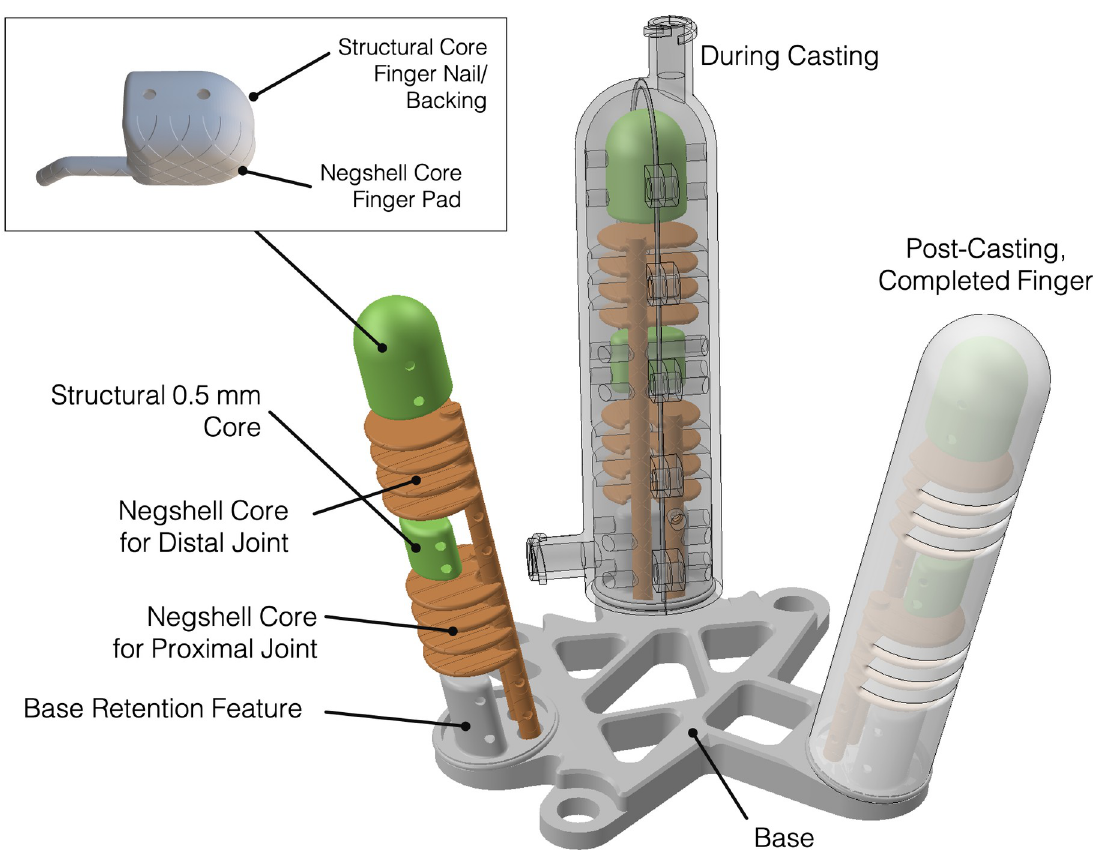
Fig 15. Overview of three-finger gripper’s fabrication. The 3D-printed base, which serves as a part of the mold for the fingers, provides a rigid connection from the fingers to the tool plate of the WAM Arm. Two seperate negshell cores are used for each joint of the fingers. A structural core aids in rigidity and force transmission between the joints. The fingertip contains a hybrid structural-negshell core with renders a soft finger pad and solid backing, as shown in the inset. The base also contains a retention feature geometrically similar to the structural cores, where silicone will be mechanically trapped and locked in place due to the